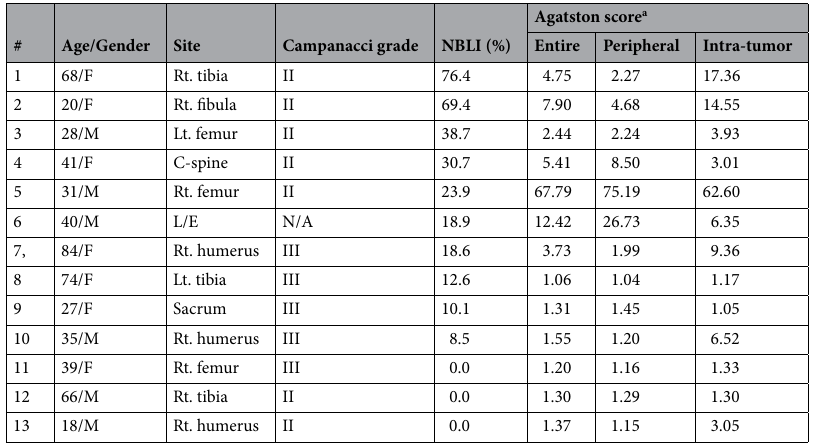
Table 1. Patient characteristics, with distribution of nuclear β-catenin and quantification of tumor ossification. C-spine cervical spine; L/E lower extremity (Soft tissue recurrence); Lt left; NBLI Nuclear β-catenin labeling index; N/A not acquired; Rt right. a Each Agatston score of post-denosumab treatment was normalized against the pre-treatment